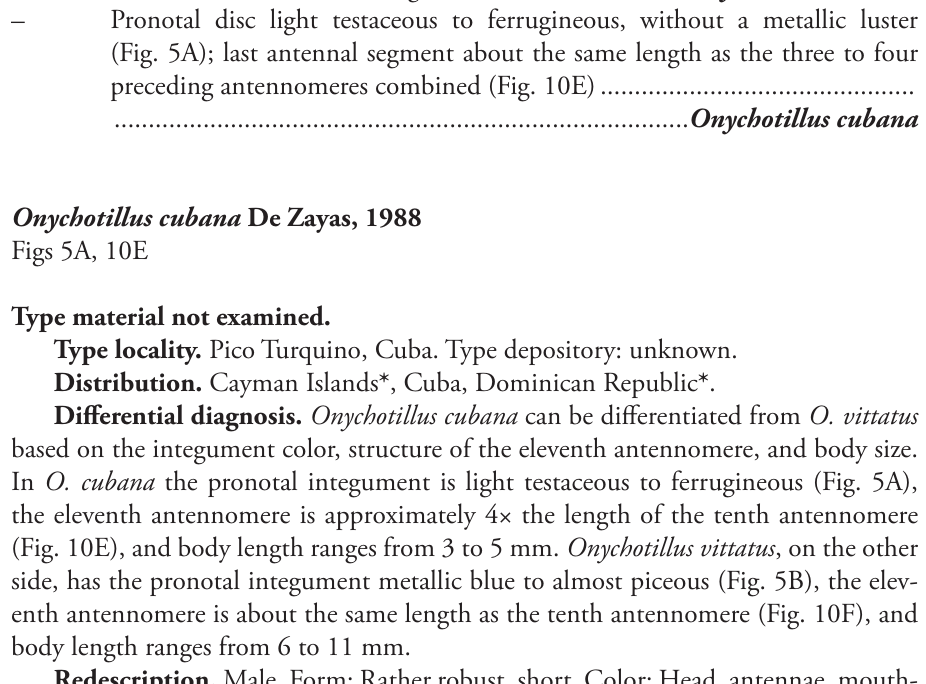
body length ranges from 6 to 11